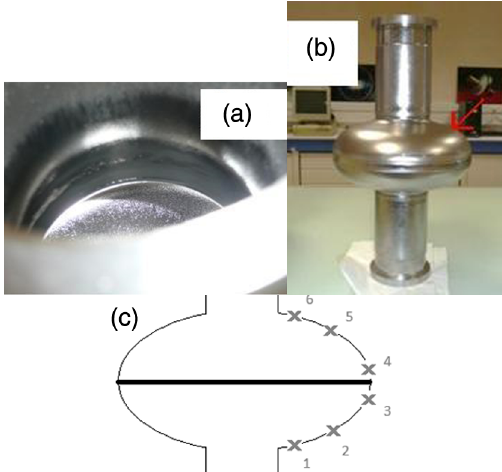
FIG. 2. (a) Inspection of the inner surface of “ 1AC3 ” cavity after VEP at 12 V − 30 ° C. A ring of pits observed at the location indicated by a red arrow on (b). For further study of material removal, single-cell cavities were carved at six locations according to (c).